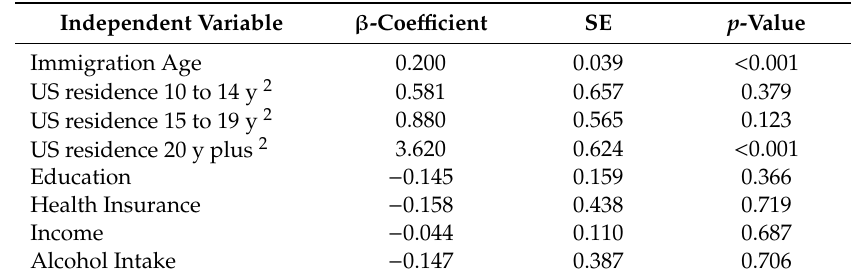
Table 3. Multiple Regression with CVD-Risk as the Dependent Variable in the Immigration-Age < 20 y Group. Adjusted R 2 : 31% ( n = 110) 1 .